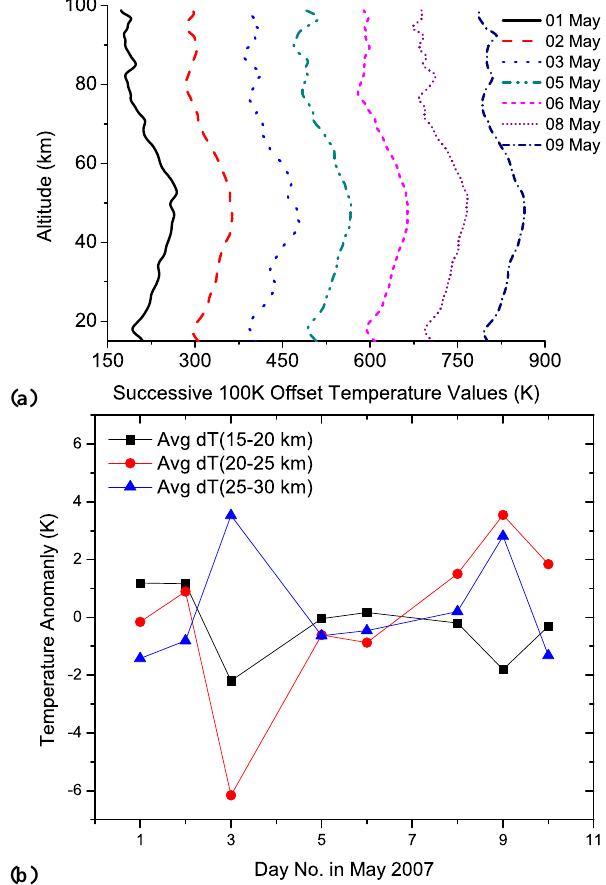
Fig. 3. (a) Atmospheric thermal structure variability obtained from SABER instrument onboard the TIMED satellite from 1 to 9 May 2007 (shifted by 100K) for the grid covering latitudes: 20– 30 ◦ N, and longitudes: 60–80 ◦ E. (b) The layer averaged (15–20, 20–25 and 25–30km) temperature deviations from the mean ther- mal structure for 1–9 May